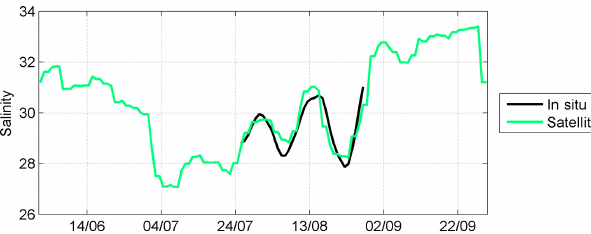
Figure 2. Time series of in situ and remotely sensed 8d running mean salinity at the M1 location in